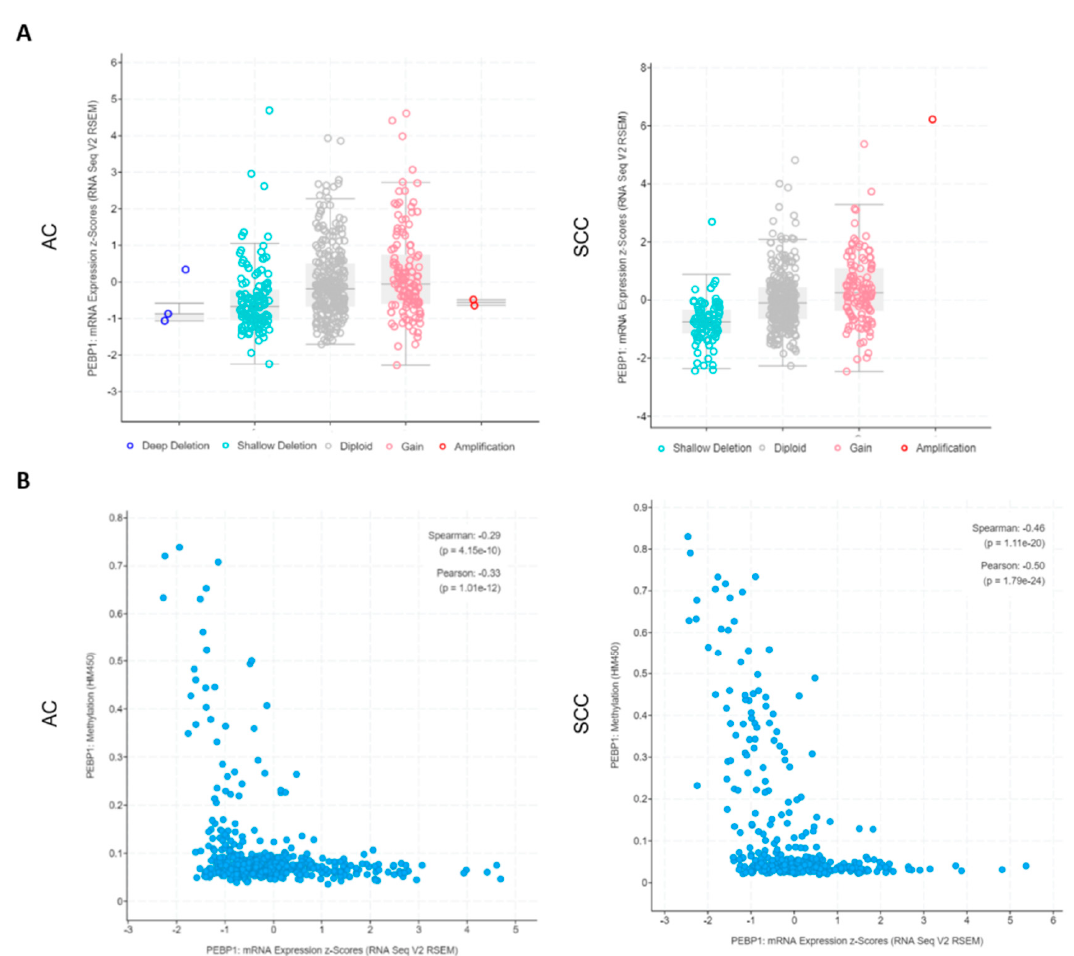
Figure 3. NSCLC TCGA data regarding RKIP encoding gene ( PEBP1 ) alterations. ( a ) RKIP mRNA